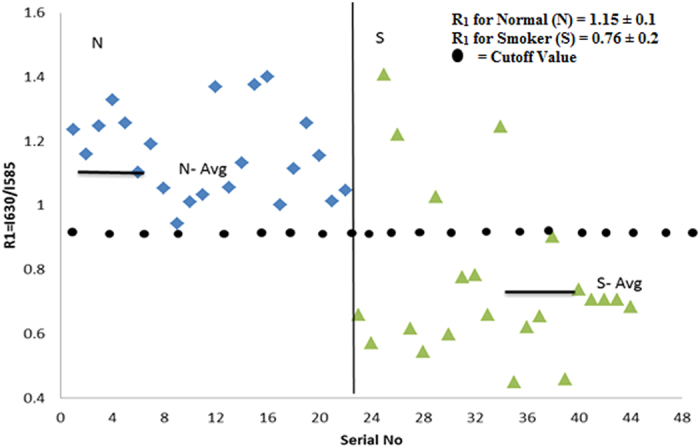
Distribution of R1 = I630/I585 ratios, as obtained from Fig. 1.N- Control sample, S- Smoker sample.